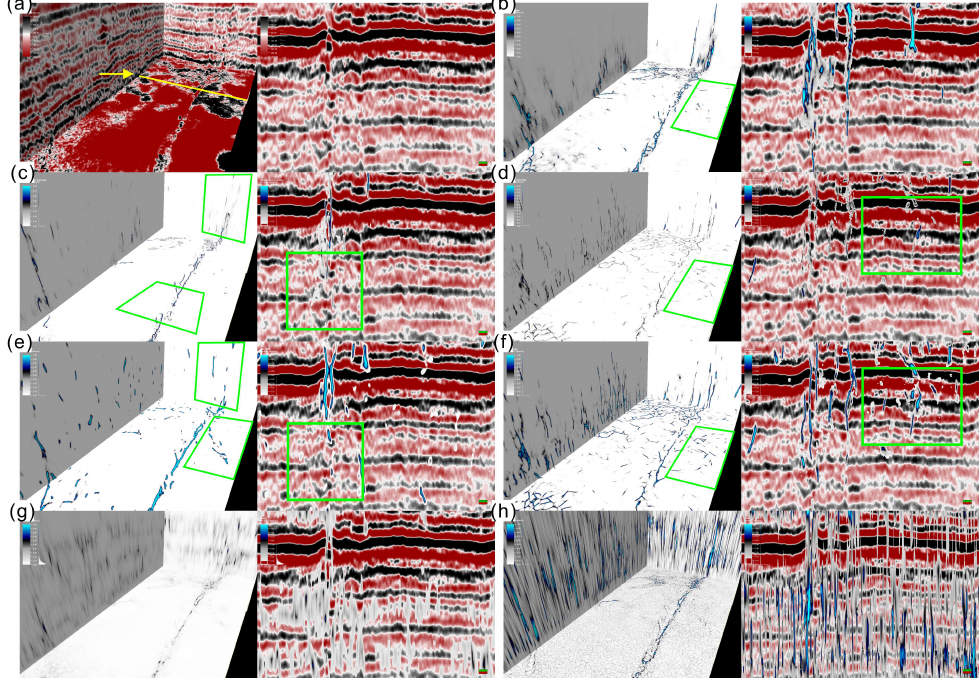
Figure 11. Fault recognition results of work area B. ( a ) Field seismic data. The yellow line represents the position of the detailed slice. ( b ) Detected faults by our structural data augmentation method. ( c ) Detected faults by Net_manual [62]. ( d ) Detected faults by Net_transfer [118]. ( e ) Detected faults by Net_syn_Wu [68]. ( f ) Detected faults by Net_syn_our. ( g ) Detected faults by Coherence [19]. ( h ) Detected faults by Curvature